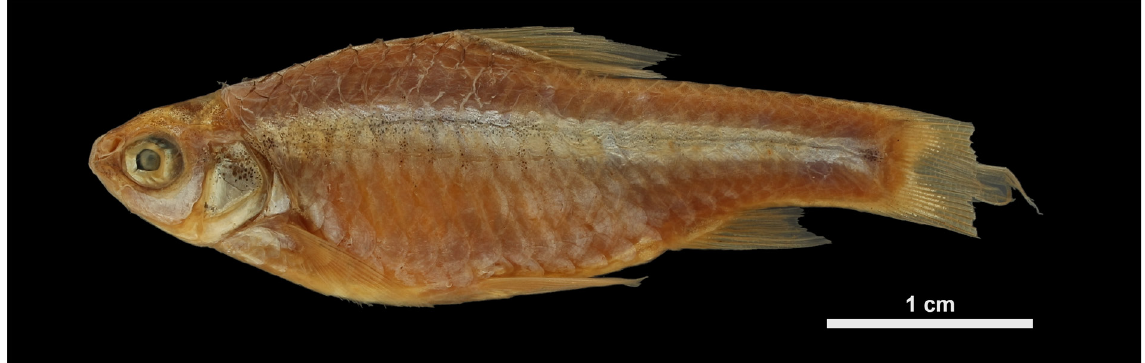
Fig. 8. Lectotype of Enteromius mimus (Boulenger, 1912) (BMNH 1912.3.22.99) with 43.6 mm